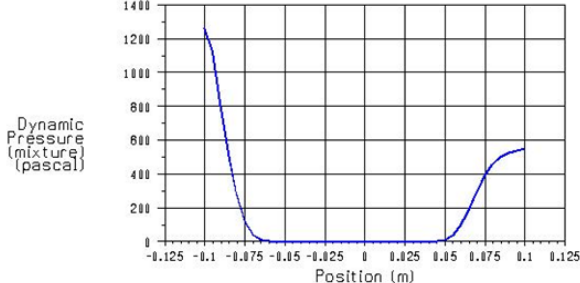
Fig. 3-12: Profile of the dynamic pressure in the vertical plane of the outlet section – a model of the vortex valve